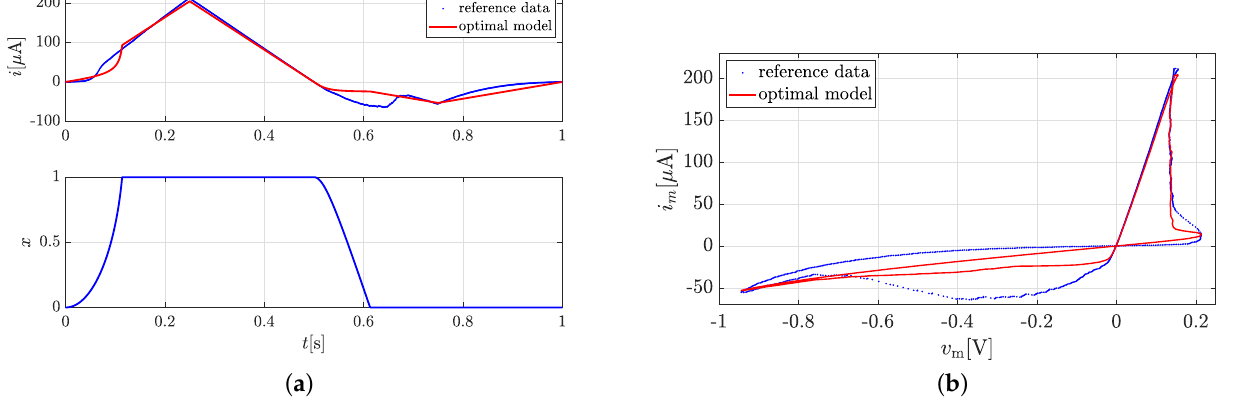
Figure 5. Optimization results obtained for the Strukov model with rectangular window for memristor with tungsten dopant and triangle wave excitation voltage with f = 1Hz and V t = 1.22V. F ( x ) = 2.1421 × 10 − 2 . ( a ) Comparison graph of the memristor current obtained from the model and the reference data, and the internal variable x ( t ) ; ( b ) Corresponding i m − v m plot.